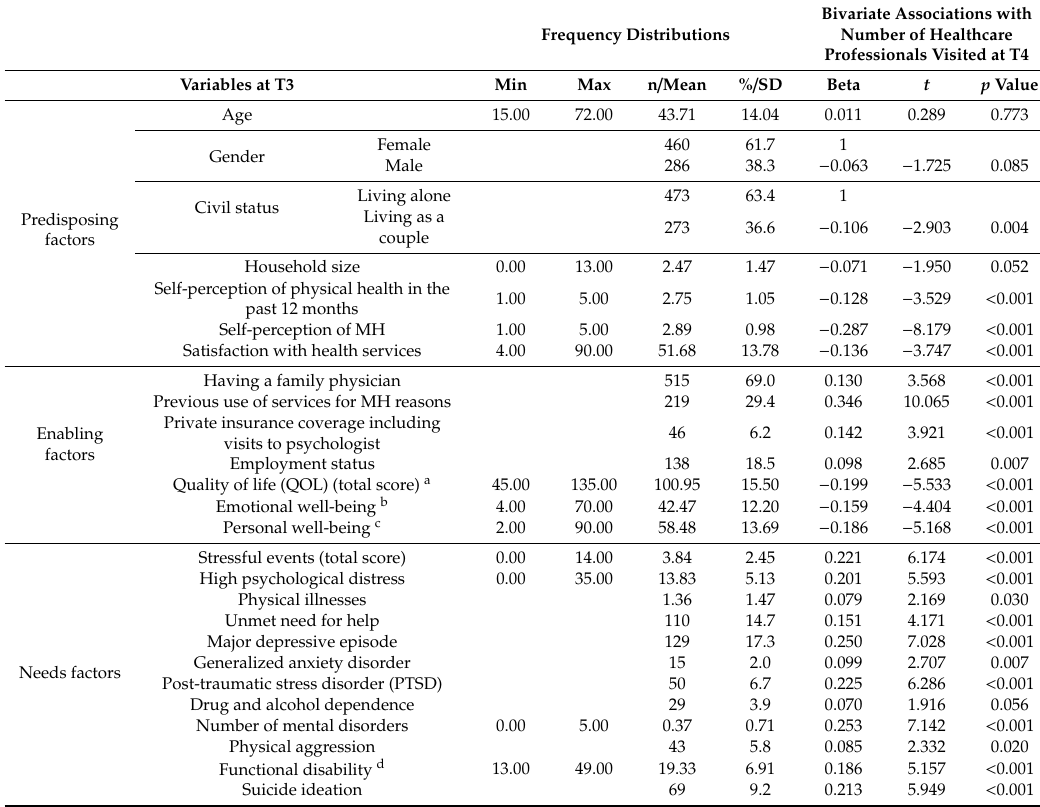
Table 2. Participant characteristics and bivariate associations with number of types of healthcare professionals consulted for mental health (MH) reasons (N = 746).